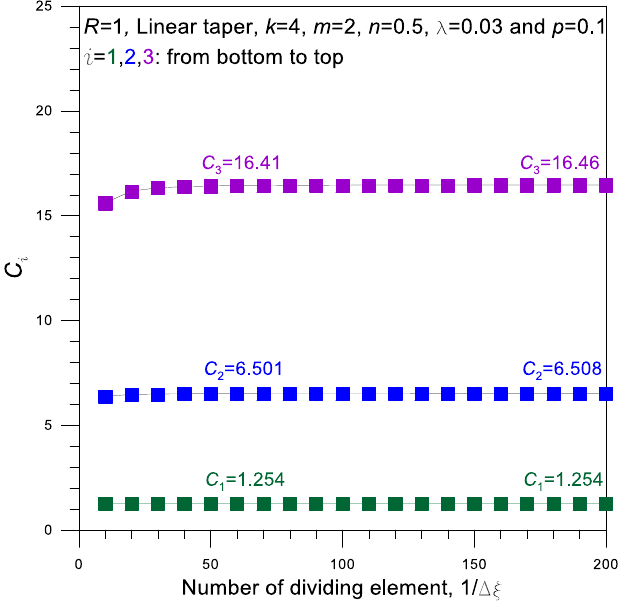
Figure 2. Convergence analysis.